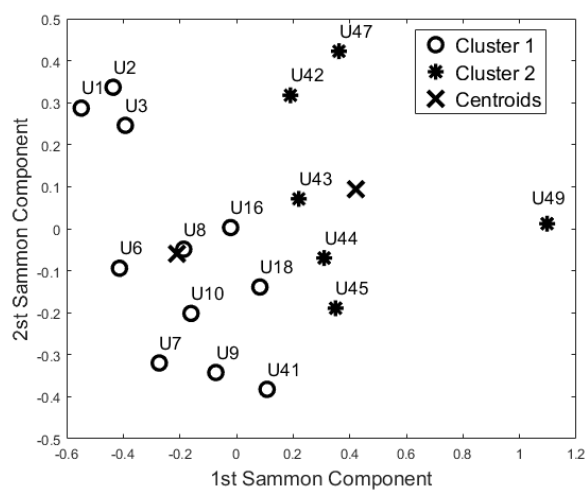
Figure 6. Cluster analysis of Bedroom Activity (K-Means and Self-Organizing Maps).